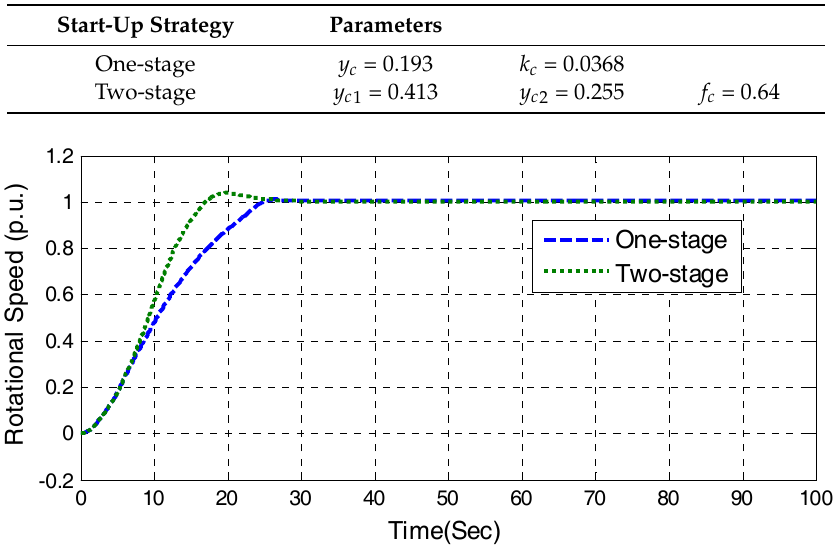
Table 10. Optimized DGVC parameters in optimization Scheme B.